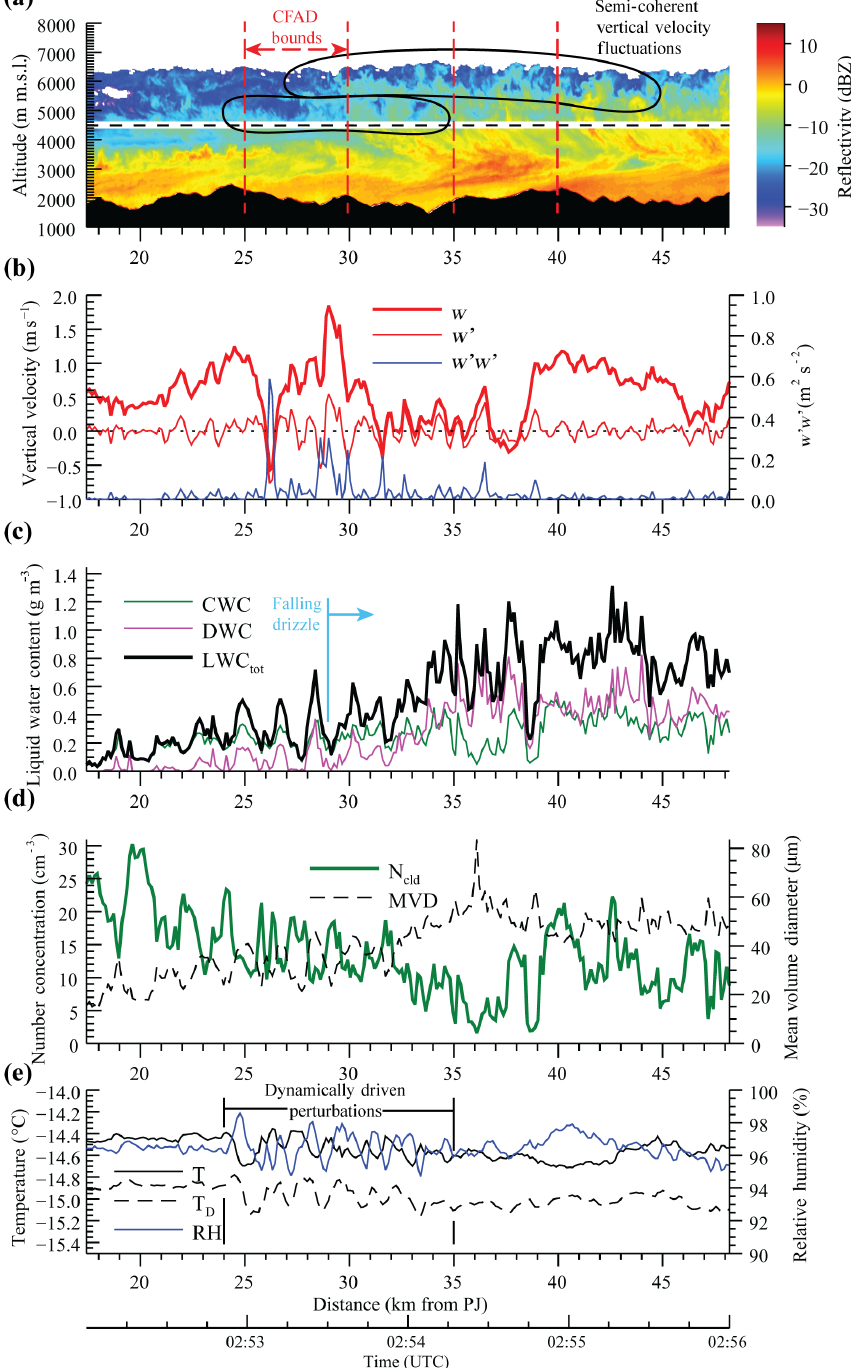
Figure 5. Detailed radar and in situ measurements for the drizzling portion of leg 1. Spatiotemporal vertical cross sections of radar reflectivity are shown in (a) . Panels (b) through (e) are derived from flight-level in situ measurements and show (b) vertical air velocity ( w ), computed perturbation vertical velocity ( w (cid:48) ), and the variance of the perturbation vertical velocity ( w (cid:48) w (cid:48) ); (c) liquid water content derived from cloud droplets (CWC), drizzle drops (DWC), and both combined (LWC tot ); (d) cloud droplet number concentration ( N cld ) and DSD mean volume diameter (MVD) for all hydrometeors with D < 1 . 2mm; and (e) temperature ( T ), dew point ( T D ), and relative humidity (RH). The CFAD bounds shown in (a) correspond to the columns for Fig. 8a–c. Perturbation vertical velocities in (b) were calculated by subtracting a boxcar- smoothed (over 10s or roughly 1km) vertical velocity field from the measured vertical velocity and represent the sub-kilometer vertical velocity